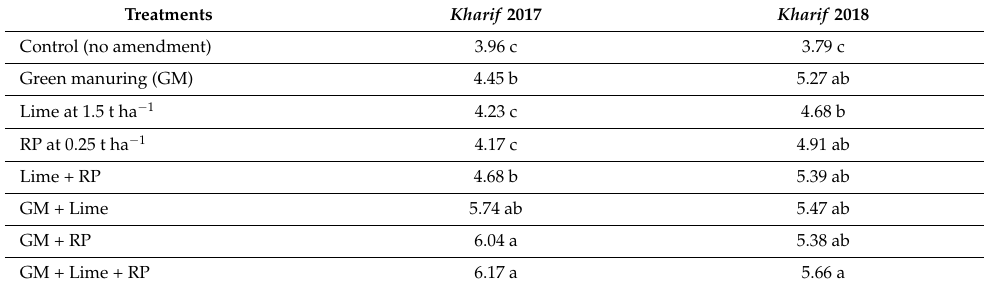
Table 6. Rice grain yield (t ha − 1 ) in Kharif 2017 and 2018 under acid saline soil management.